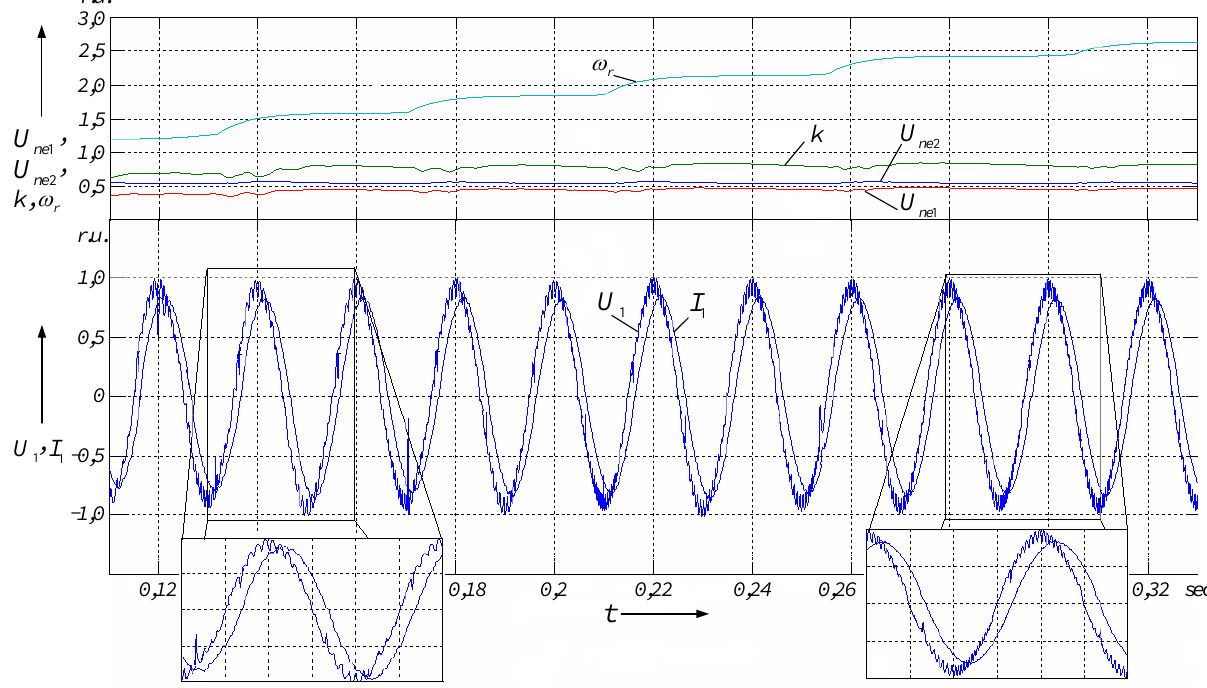
Figure 10. Load voltage and current waveforms of MCS when changing rotational speed of driving shaft while stabilizing output electrical parameters of MCS by means of AC excitation winding